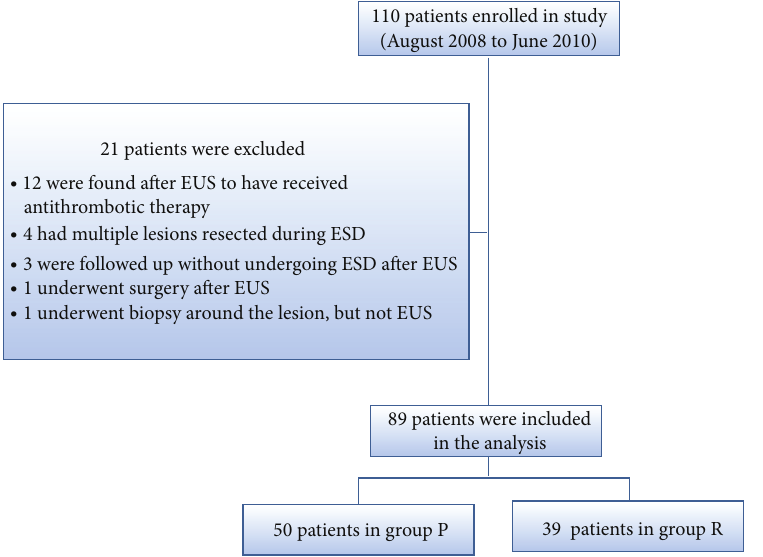
Figure 1: Flow of patients through this study.